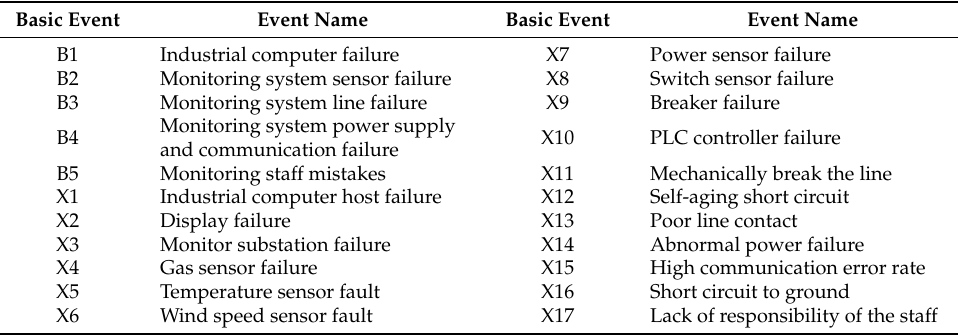
Table 1. Fault tree event table of a gas monitoring system.